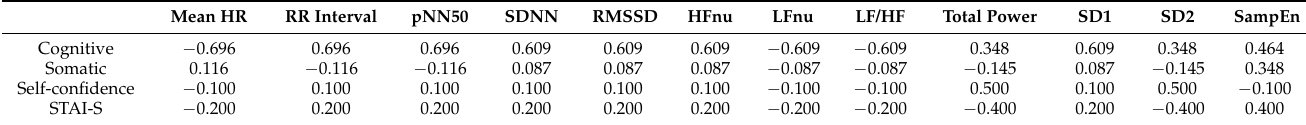
Table 5. Correlation between HRV and precompetitive values before the second